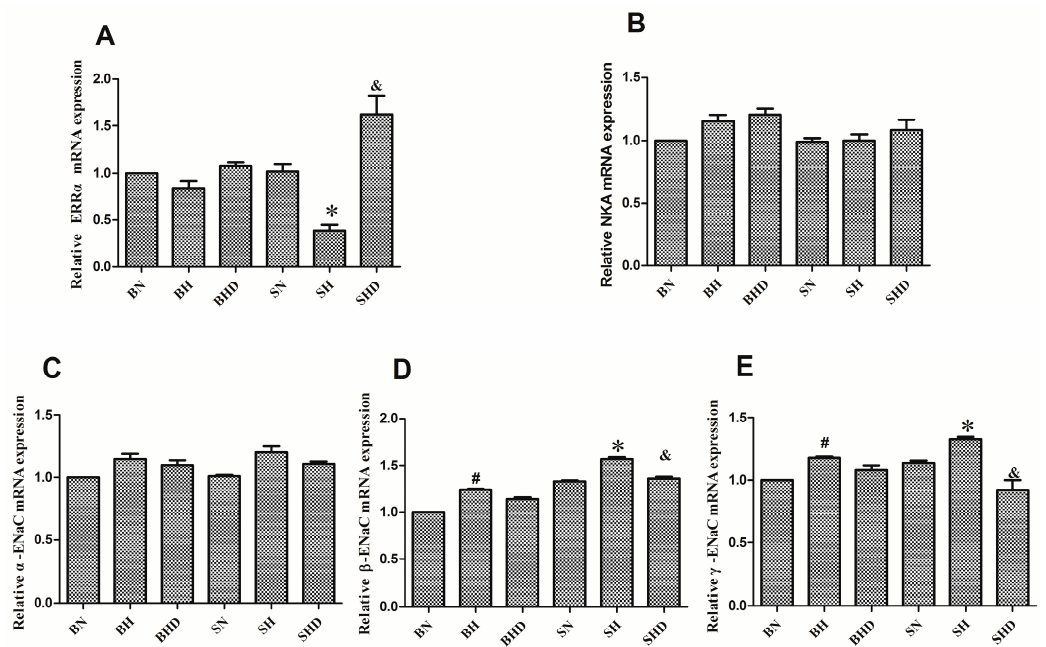
Figure 2. Expressions of ERR α , Na + /K + -ATPase, α -epithelial sodium channel ( α -ENaC), β -ENaC and γ -ENaC mRNA after intervention. * p < 0.05, compared with BH, SN, and SHD groups. # p < 0.05, compared with BN group. & p < 0.05, compared with BHD group. ( A ) relative ERR α mRNA; ( B ) relative Na-K-ATPase mRNA; ( C ) relative α -ENaC mRNA; ( D ) relative β -ENaC mRNA; ( E ) relative γ -ENaC mRNA.